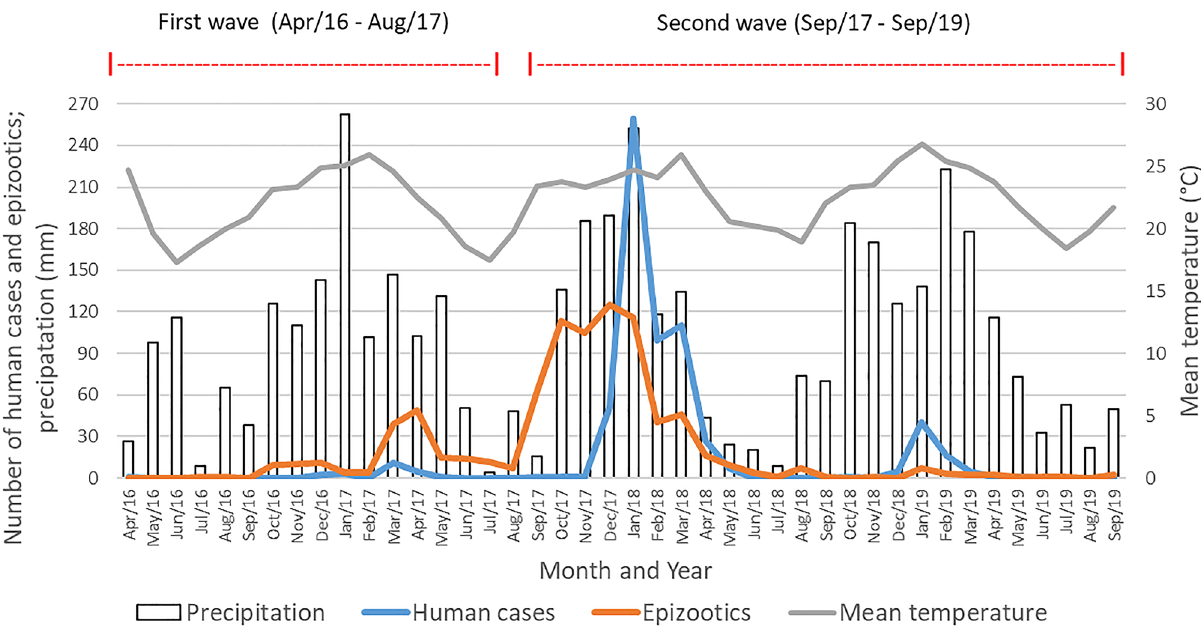
Figure 3. Autochthonous human cases, per month of symptom onset, and epizootics, per month of notification, of yellow fever and the two outbreak waves; precipitation and mean temperature; state of São Paulo, 2016 and